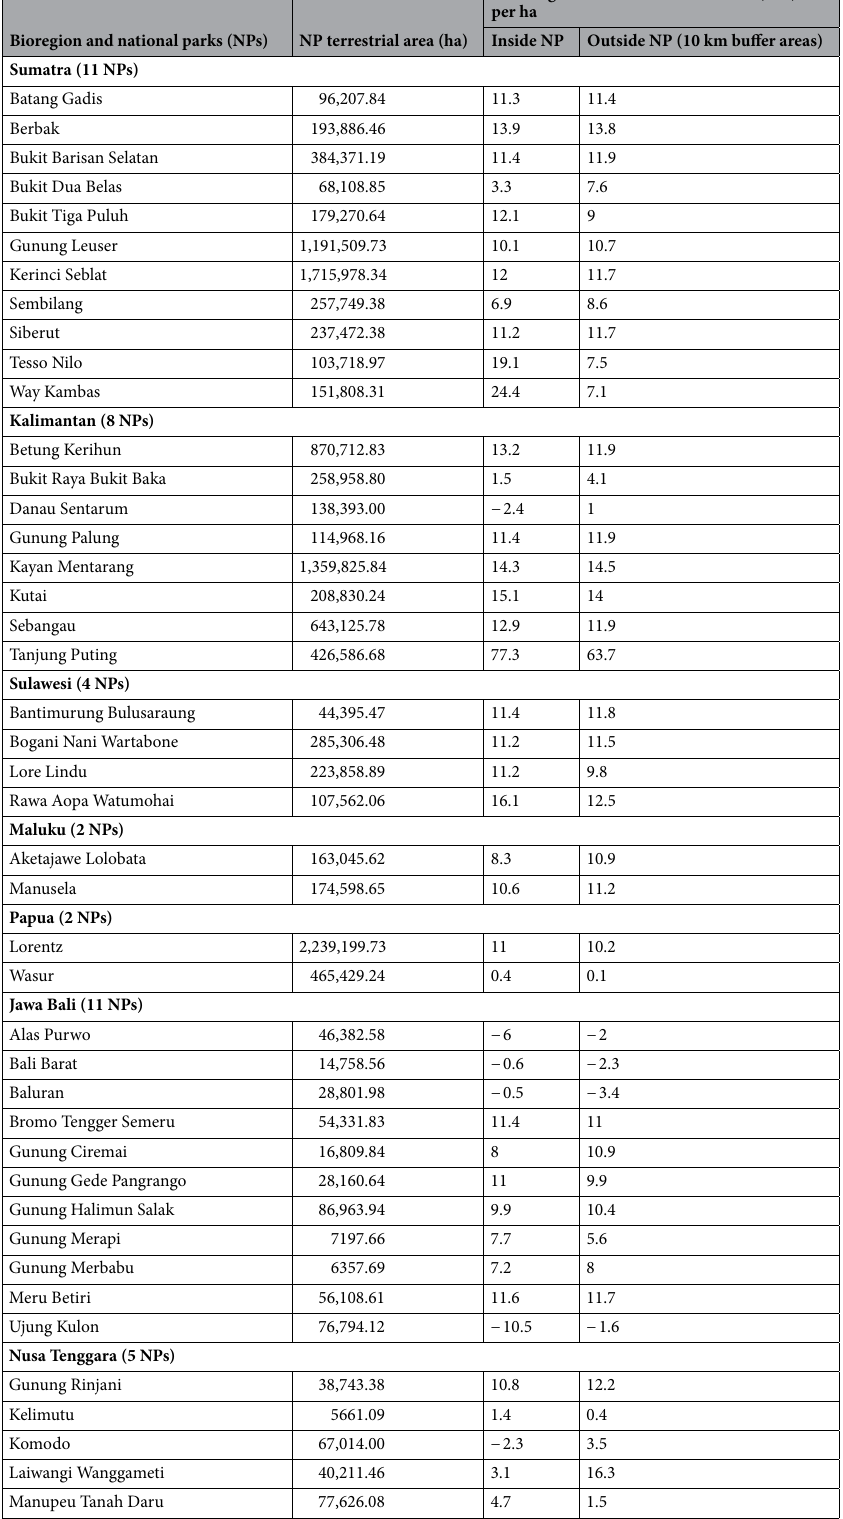
Table 1. Changes in Human Footprint (Human Influence Index scores), inside and outside 43 terrestrial national parks in Indonesia between 2012 to